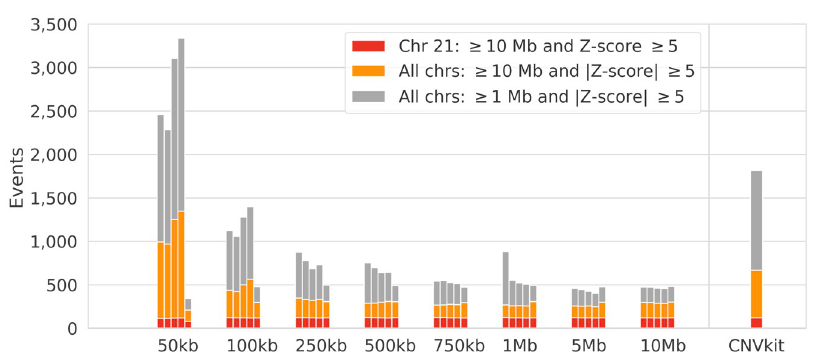
Fig 1. Bin size relation to detection rate. Stacked counts of detected CNVs relative to bin size and method, ordered from left to right as: WCR , WCR+SE , WCR+PE , WCR+PEI , WCRX (CNVkit results are displayed separately). Bar coloring denotes mutually exclusive filtering constraints. Red: filtering for � 10 Mb CNVs with Z-score � 5 (only including duplications) and only on chromosome 21. Orange: filtering for � 10 Mb CNVs with an absolute Z- score � 5 (thus also including deletions) and on all chromosomes. Gray: identical to the previous but for all CNVs � 1